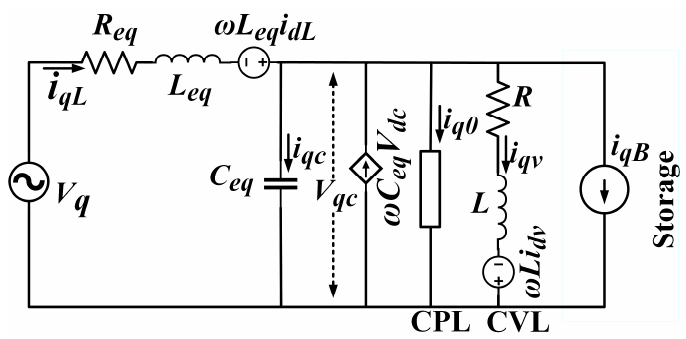
Figure 5. Reactive power compensation method at the load side, modeled for q-axis.